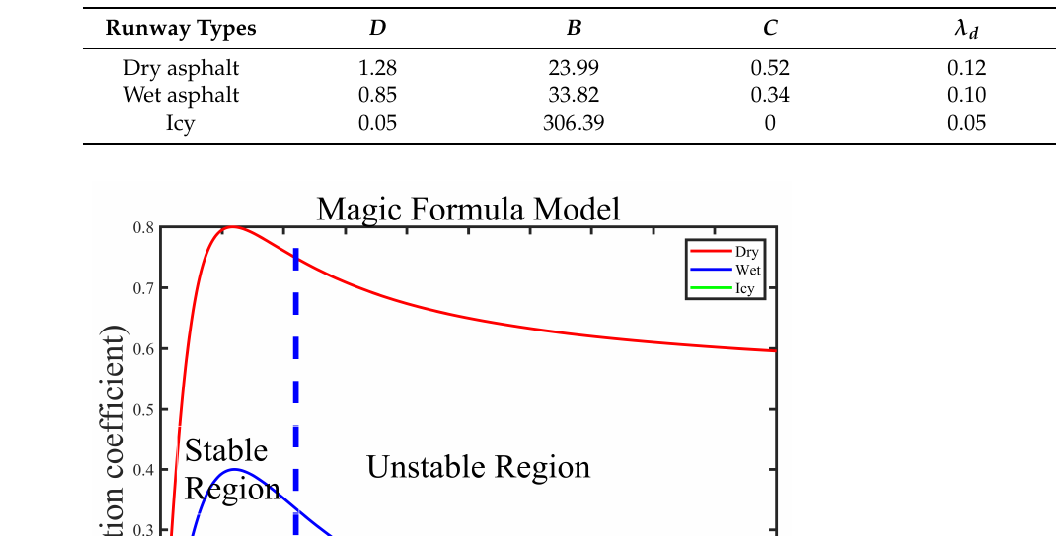
Table 1. Magic formula model parameters.